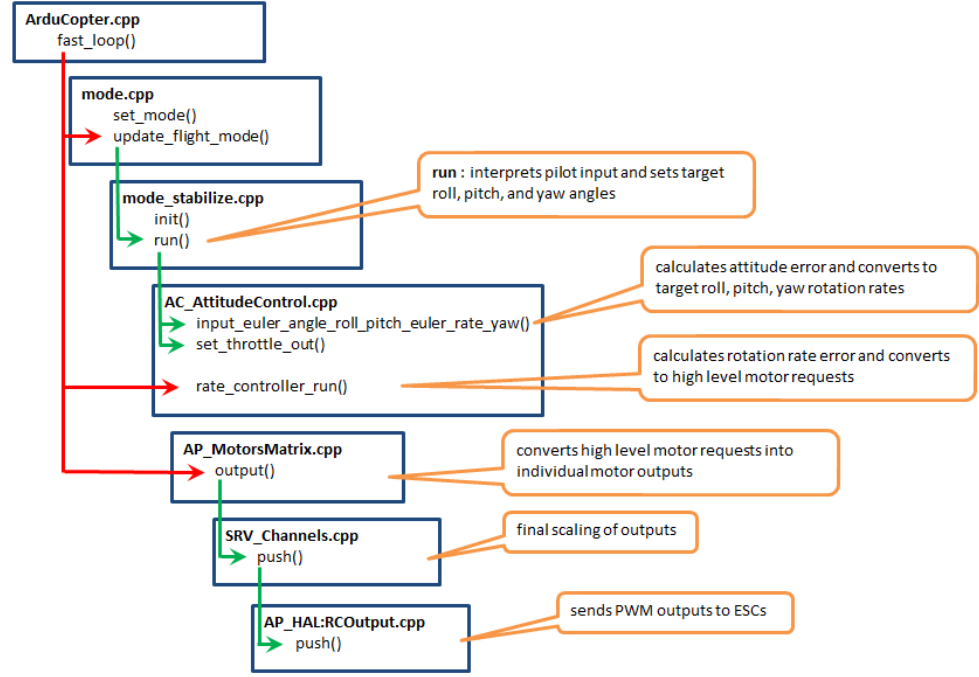
Figure 22. A high-level architecture overview of the ArduCopter software—a sequence of actions in a manually controlled flight mode; image source: https://ardupilot.org/dev/docs/apmcopter- code-overview.html, accessed on 1 May 2022 published under the CC BY-SA 3.0 license: https: //creativecommons.org/licenses/by-sa/3.0/legalcode, accessed on 1 May 2022.